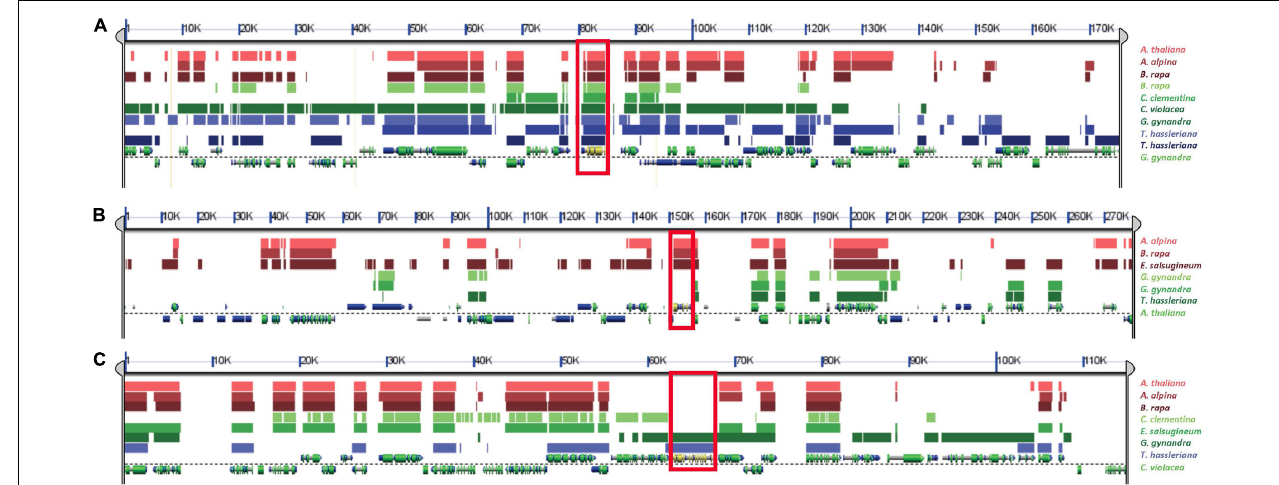
FIGURE 5 | Syntenic relationships of β -NAD-ME and α -NAD-ME genes across Cleomaceae, Brassicaceae and outgroup genomes using SynFind and GEvo analysis. (A) A search for syntenic regions based on the β -NAD-ME1 gene in G. gynandra (as reference region) identified syntenic homologs in all species (shown in red box), including the outgroup species C. clementina . Also, all duplicated copies found by phylogenetic analysis of β -NAD-ME , for example in B. rapa and T. hassleriana , were also syntenic which supports that they are derived from ancient polyploidy events. (B) A search for syntenic regions based on the A. thaliana (Brassicaceae) copy of α -NAD-ME identified only single copy syntenic homologs (shown within red box) in other Brassicaceae species ( A. alpina , E. salsugineum , and B. rapa ) but not with Cleomaceae species ( C. violacea , G. gynandra , and T. hassleriana ) nor the outgroup species C. clementenia . Similarly, (C) A search for syntenic homologs of the C. violacea α -NAD-ME gene (shown within red box) found them only in the other Cleomaceae species ( G. gynandra and T. hassleriana ) but not with Brassicaceae or the outgroup species. These combined results (B, C) suggest independent translocations of α -NAD-ME genes in the Brassicaceae and Cleomaceae to new genomic